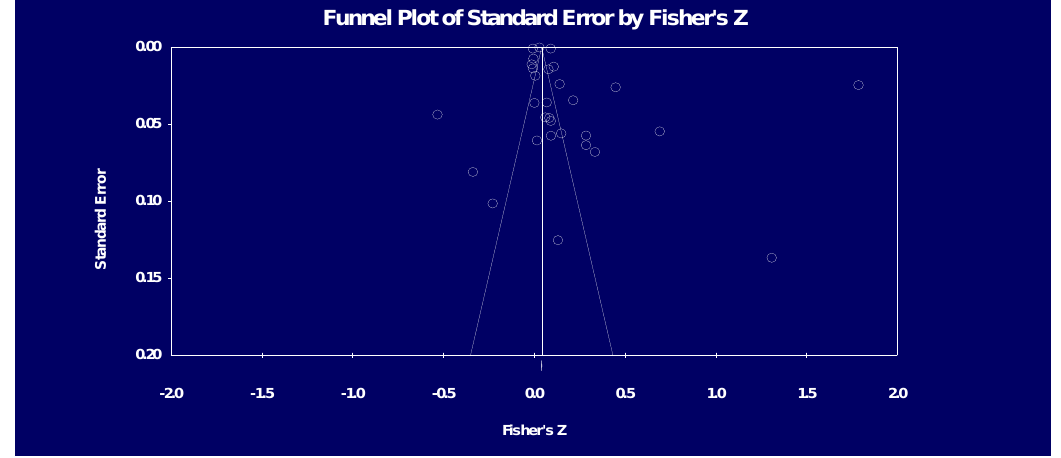
Figure 1. Distribution of effect size.